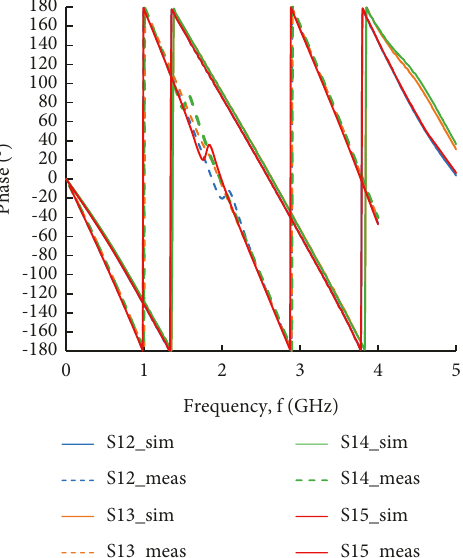
Figure 22: Simulation (dashed lines) and measurement (solid lines) phase of S 12 , S 13 , S 14 , S 15 , of the Wilkinson divider.